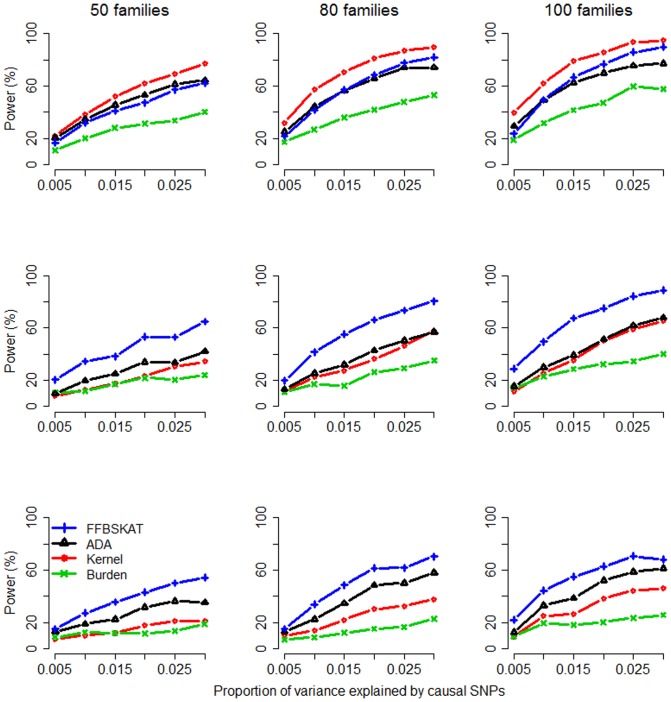
Power Comparison for continuous traits.The figure shows the empirical power given the significance level of 0.05. Top row: 50 variants included in the tests; middle row: 100 variants; bottom row: 150 variants. The x-axis is the proportion of variance explained by causal SNPs, whereas the y-axis is the power.